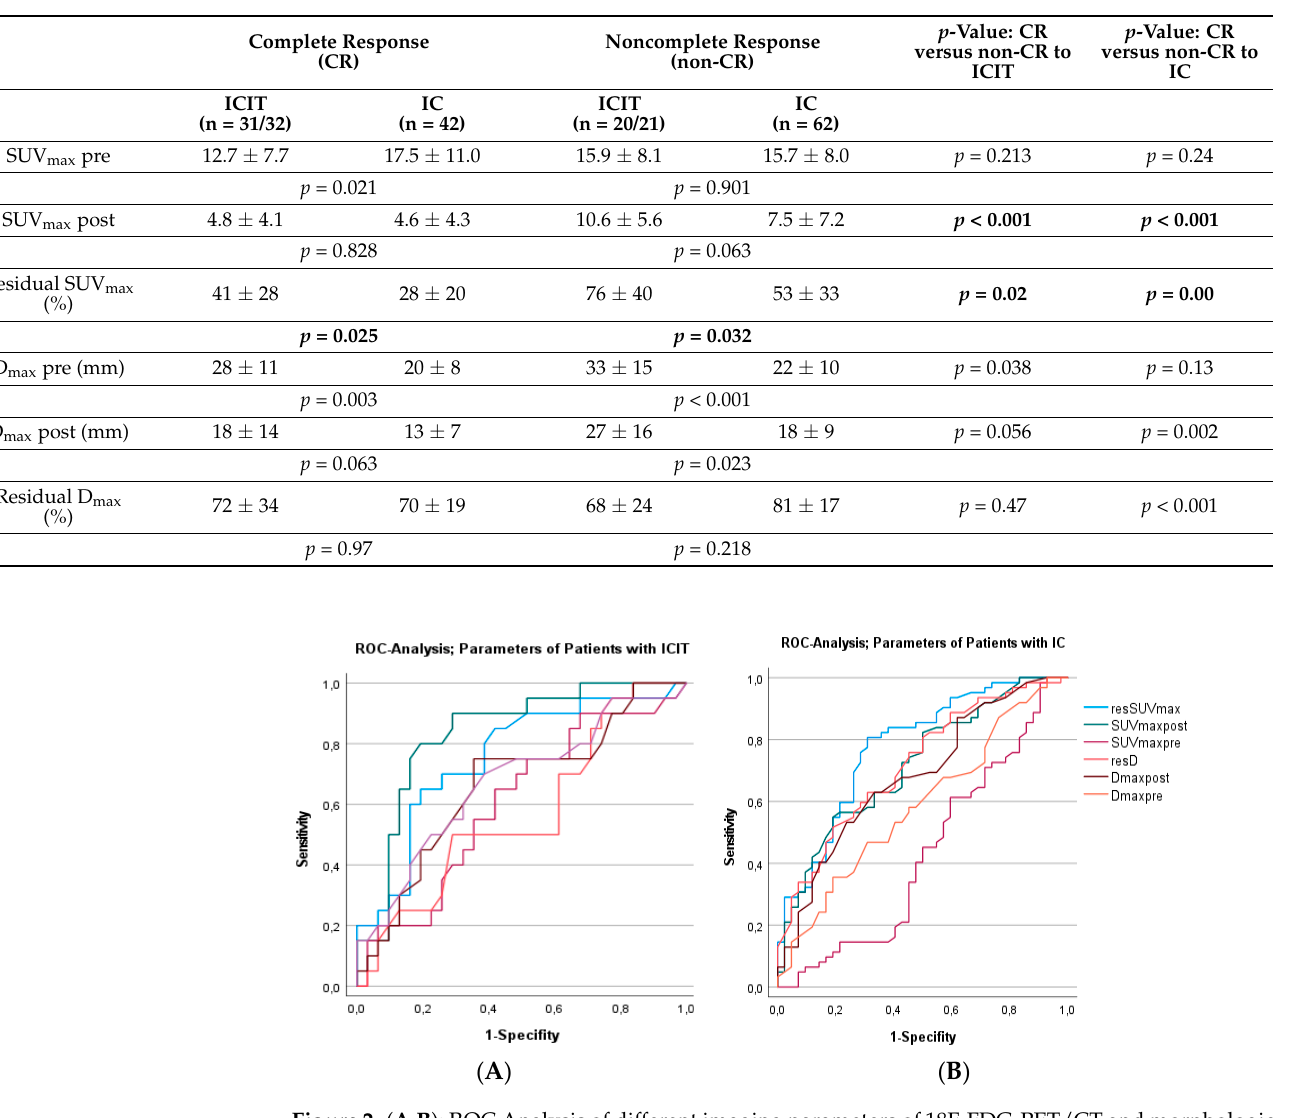
Table 2. Imaging results for morphologic and metabolic parameters of pathologic and clinical complete response (CR) and non-CR measured before (pre) and after (post) ICIT versus IC.